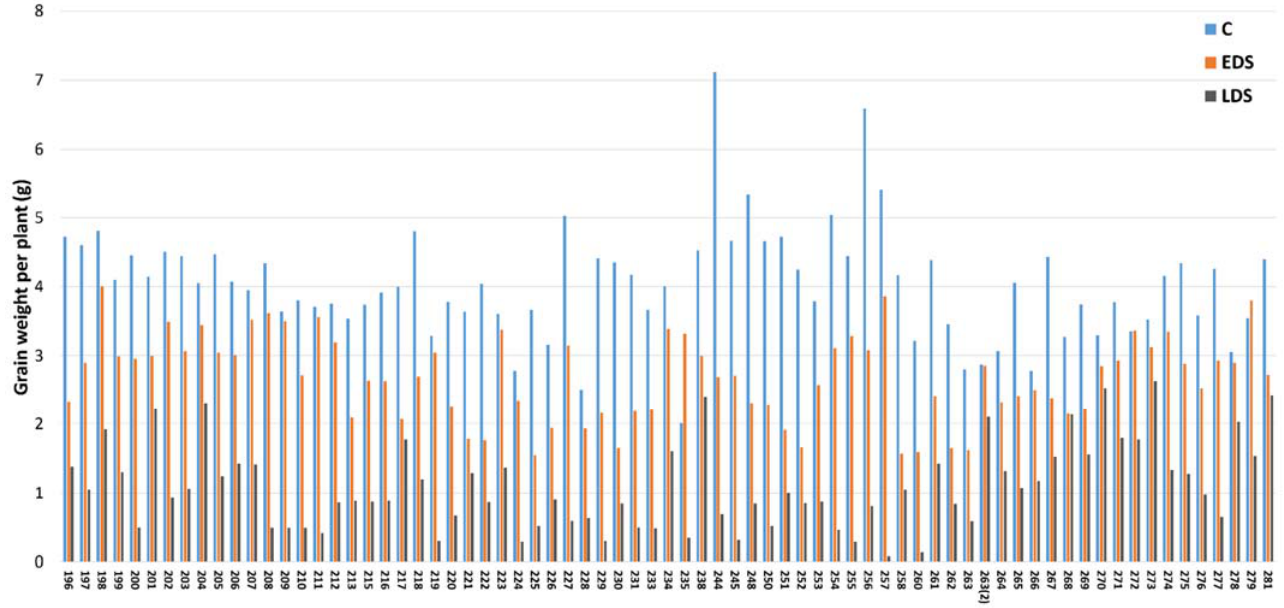
Figure 5. Yield (grain weight per plant = GWPP) of each genotype under control (C), early drought stress (EDS) and late drought stress (LDS).